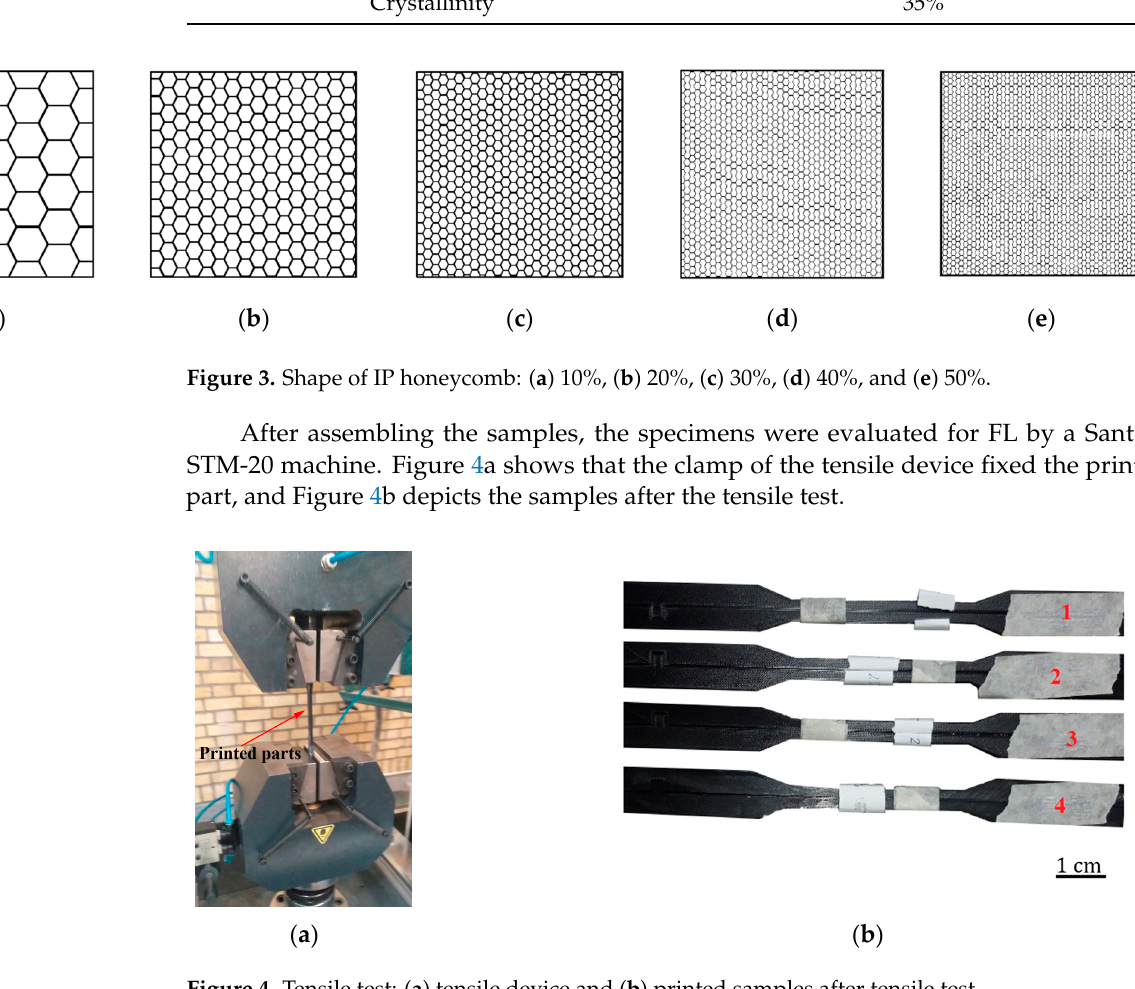
Figure 4. Tensile test: ( a ) tensile device and ( b ) printed samples after tensile test.